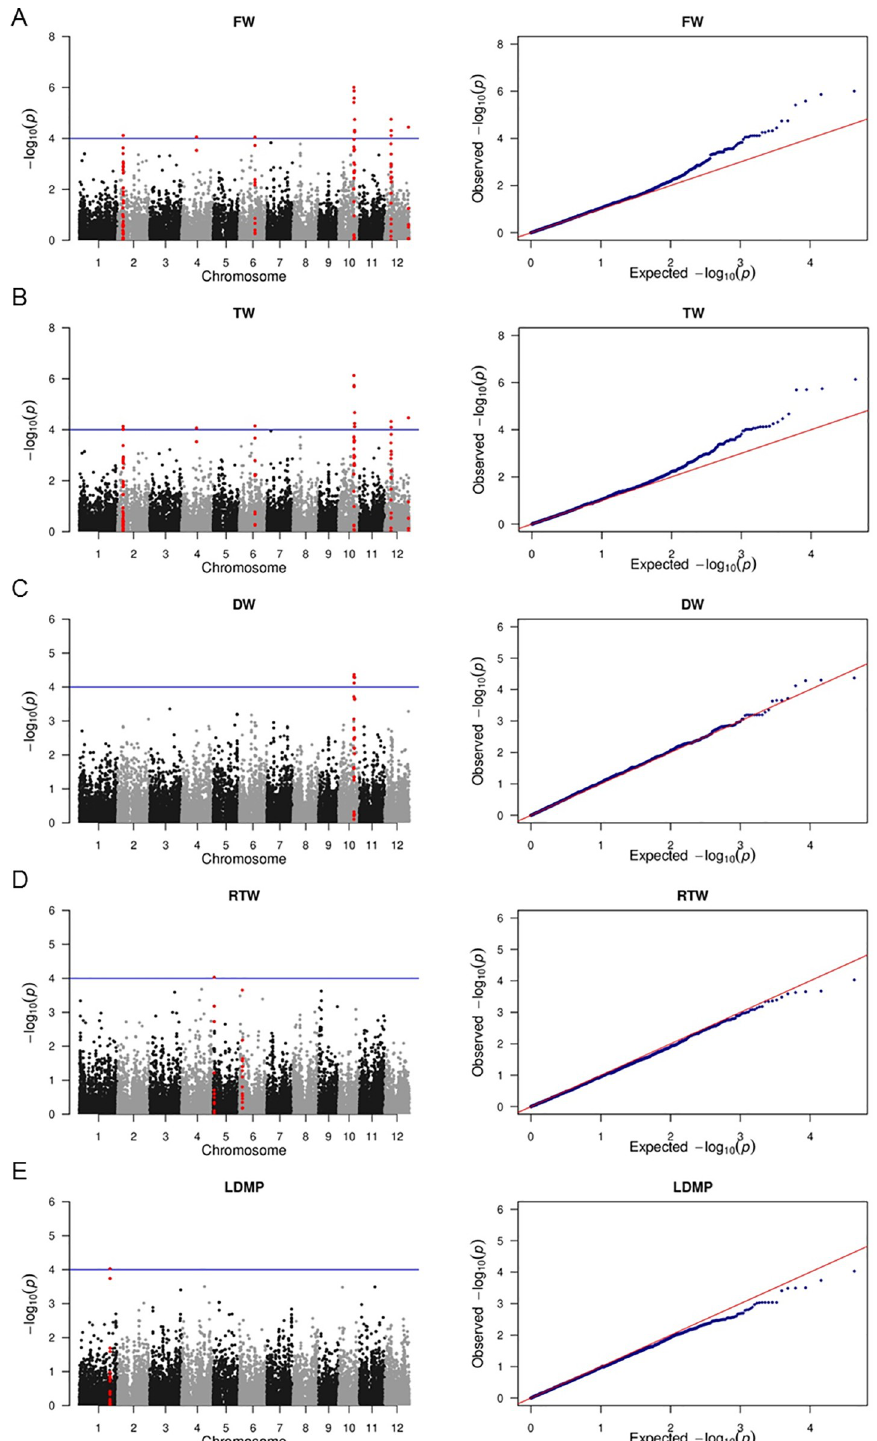
Fig 2. Manhattan plots (left) and Q-Q plots (right) for the genome-wide association study of leaf mass traits in the full panel. A: leaf fresh weight, FW; B: leaf turgid weight, TW; C: leaf dry weight, DW; C: relative tissue weight, RTW; D: leaf dry matter percentage, LDMP.